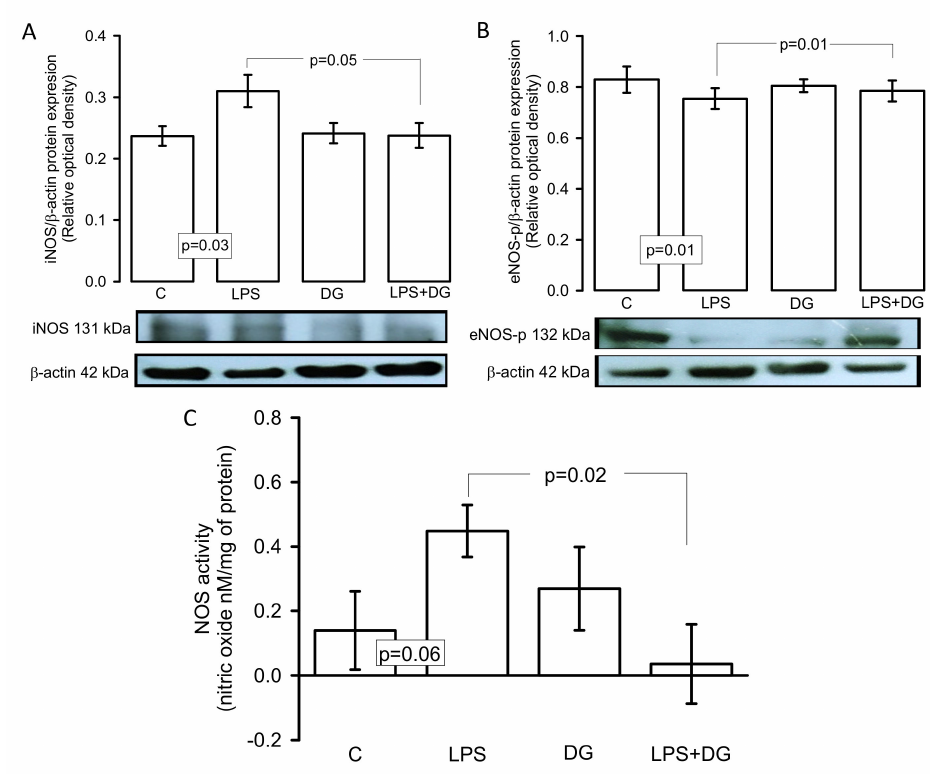
Figure 5. Expressions of the ( A ) iNOS-p expression, ( B ) iNOS expression, and ( C ) NO concentration. Values are expressed as mean ± SE (n = 6). The NOS activity was quantified using a Clark-type electrode attached to an oximeter and values are expressed as concentration of NO nM/mg of